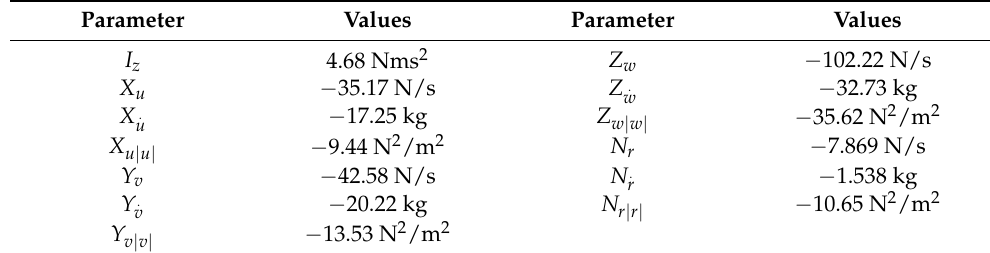
Table 2. Nominal parameters of the “Lingrui”